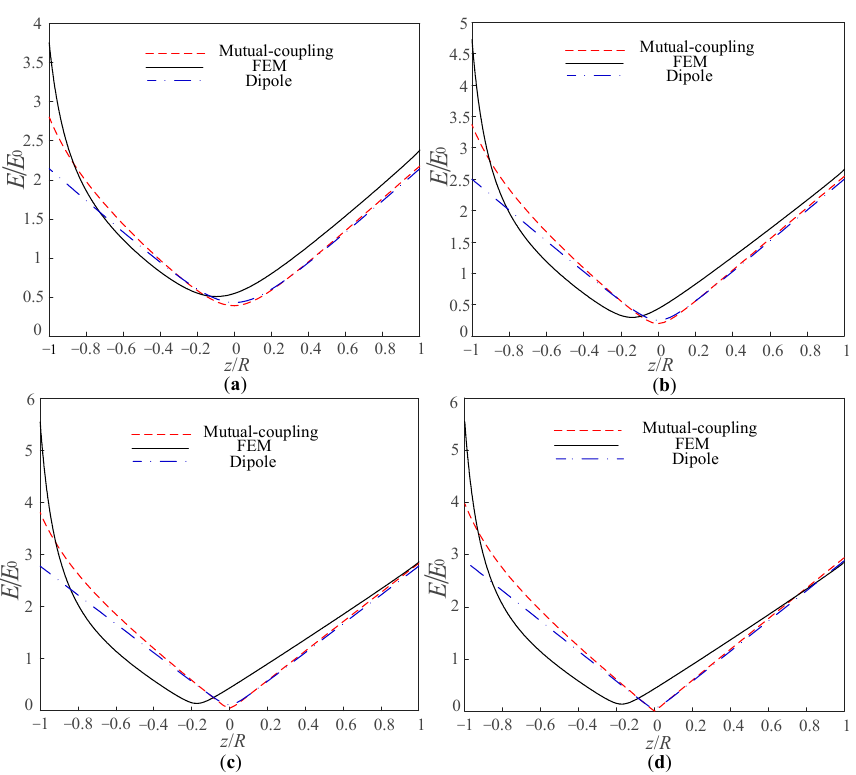
Figure 5. Calculation results of the electric field distribution on particle 1 when D / R = 0.2: ( a ) Calcu- lation results when ε i / ε e = 5; ( b ) Calculation results when ε i / ε e = 10; ( c ) Calculation results when ε i / ε e = 25; ( d ) Calculation results when ε i / ε e = 50.